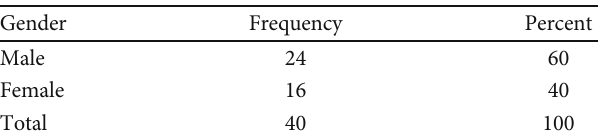
Figure 4: Treatment of a vascular malformation with sclerotherapy (sodium tetradecyl sulfate). (a) Presence of vascular malformation. (b) Intralesional injection of 0.2ml sodium tetradecyl sulfate 3%. (c) Appearance of an ulcer after 3-4 days of intralesional injection. (d) Complete disappearance of the lesion. Table 1: Details of